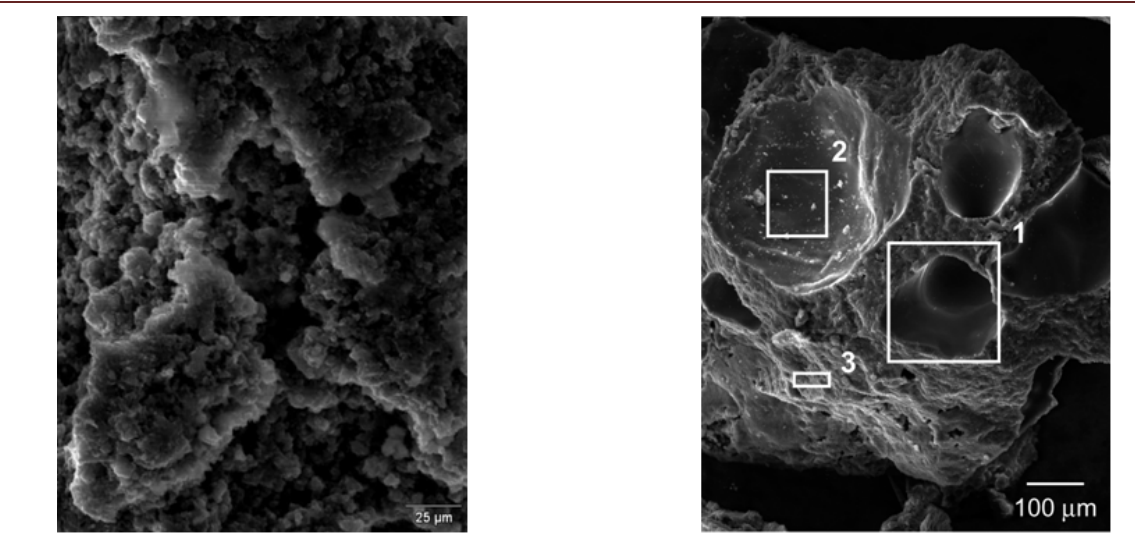
Figure 20: SEM analysis. Channels in the surface crust – 170 X.